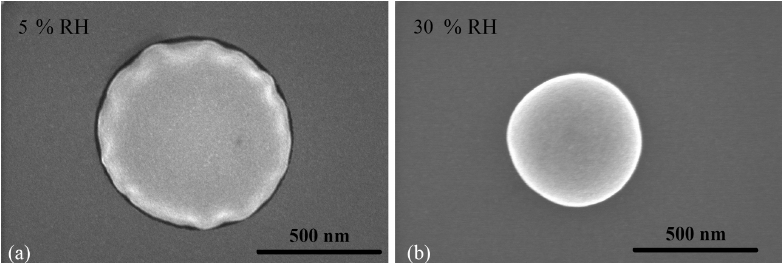
Figure 6. SEM micrographs of deposited particles composed of calcium nitrate and malonic acid before conditioning (a) and after condi- tioning at 30%RH (b)